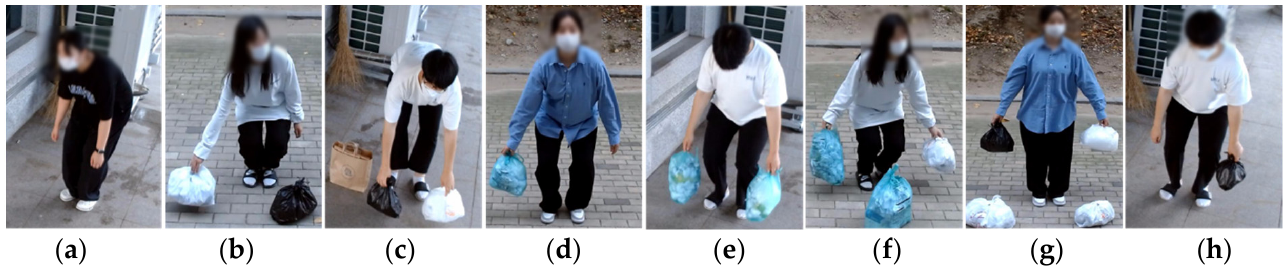
Figure 5. Eight types of scenarios (S1~S8) for the performance evaluation of the illegal dumping monitoring system; ( a ) S1—a bending posture with no garbage bag; ( b ) S2—a dumping scenario with the non-standard bag in one hand; ( c ) S3—a dumping position with the non-standard garbage bags on both hands; ( d ) S4—a dumping posture with the legal standard garbage bag in hand; ( e ) S5—a dumping scenario with legal standard garbage bags in both hands; ( f ) S6—a dumping posture with the standard bag in one hand and the non-standard bag in the other hand; ( g ) S7—a dumping posture without bending the waist with the non-standard bags in both hands; and ( h ) S8—a bending position without dumping with the non-standard